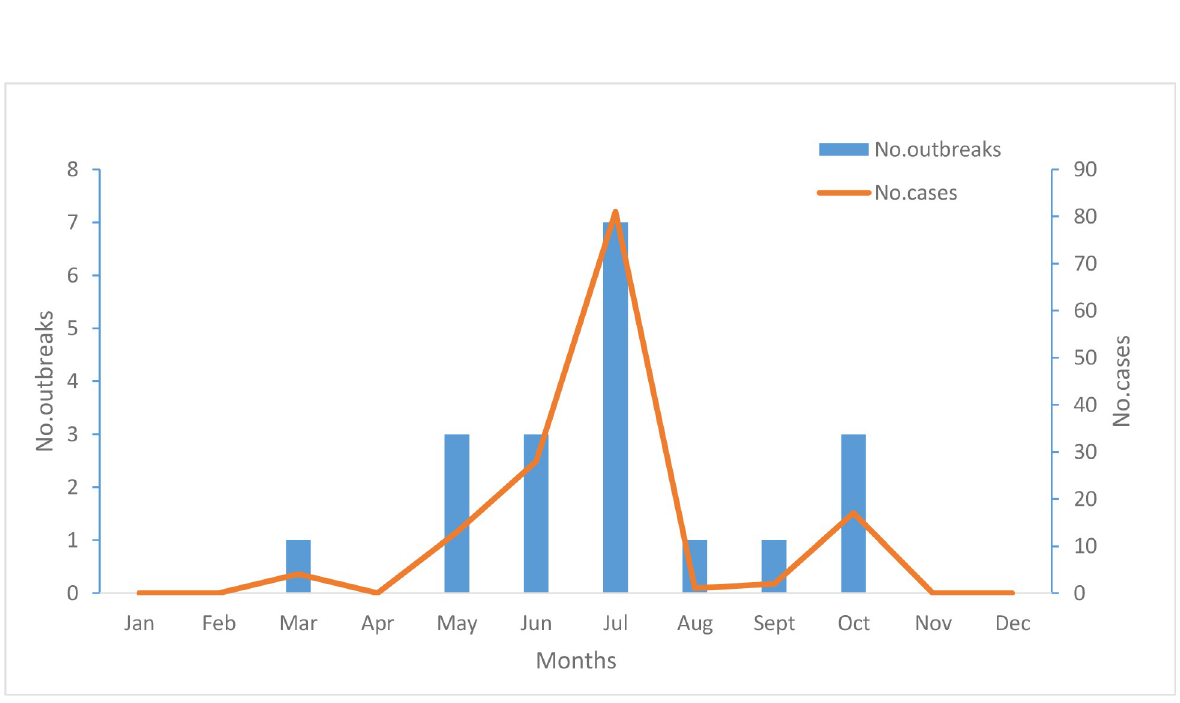
Fig 3. Reported bongkrekic acid poisoning outbreaks and outbreak-associated cases by seasons, China national foodborne diseases surveillance network, 2010–2020 (n = 19 outbreaks).